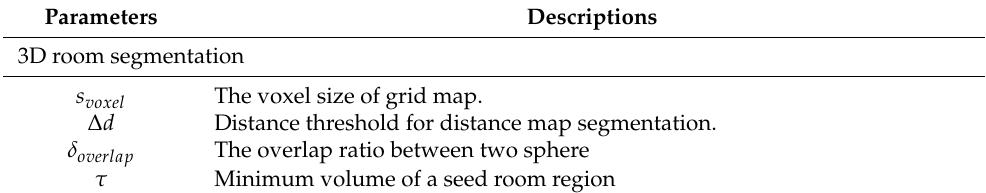
Table 6. Parameters and descriptions of the proposed method for mesh datasets.